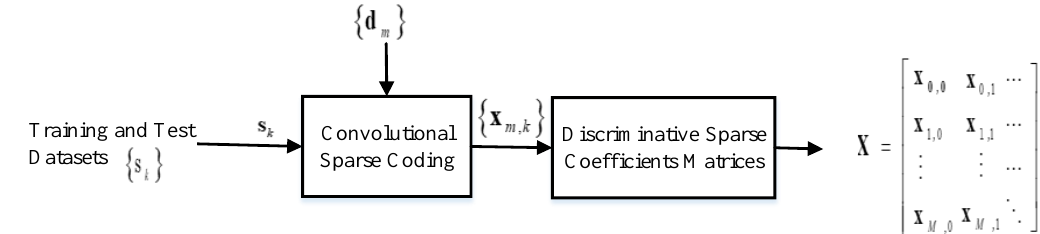
Figure 2. Extraction of sparse coefficients using convolutional sparse coding.